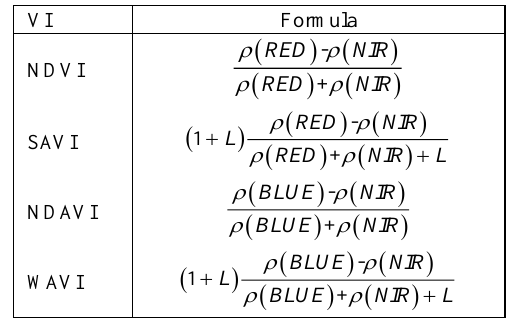
Table 1. The formulas of NDVI, SAVI, NDAVI and